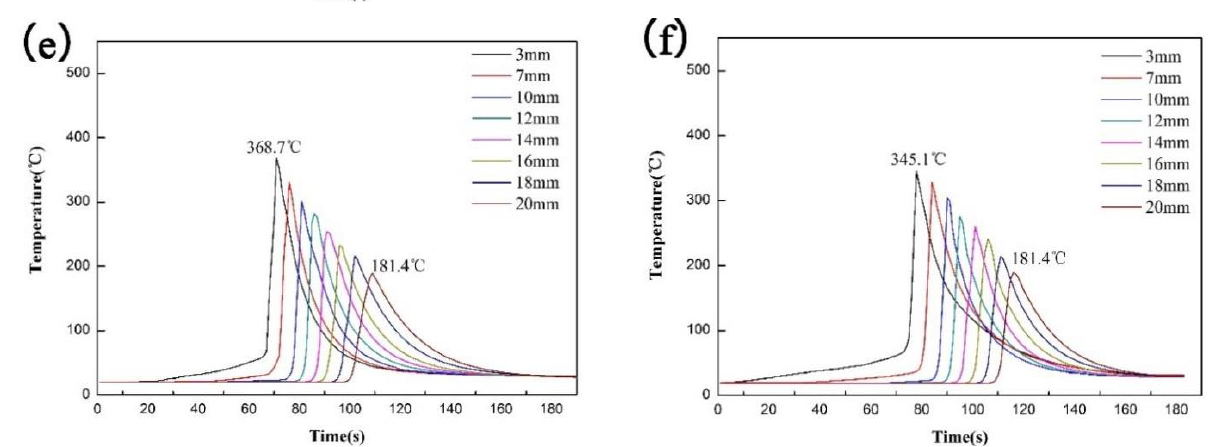
Figure 5. Welding thermal cycle curves of different tool pins. ( a ) AS of tool pin A; ( b ) RS of tool pin A; ( c ) AS of tool pin B; ( d ) RS of tool pin B; (e) AS of tool pin C; ( f ) RS of tool pin